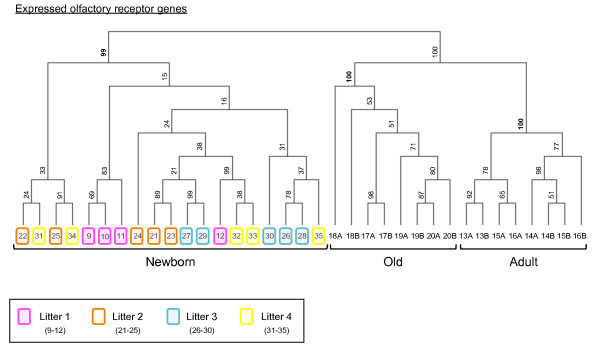
Hierarchical clustering of samples for OR genes expressed in olfactory epithelium in the three age groups of rats. Numbers at the nodes (range = 1 to 100) indicate support (bootstrap value) for the clustering. Note the high bootstrap values at each node corresponding to the age groups but their much lower values for the downstream branches.